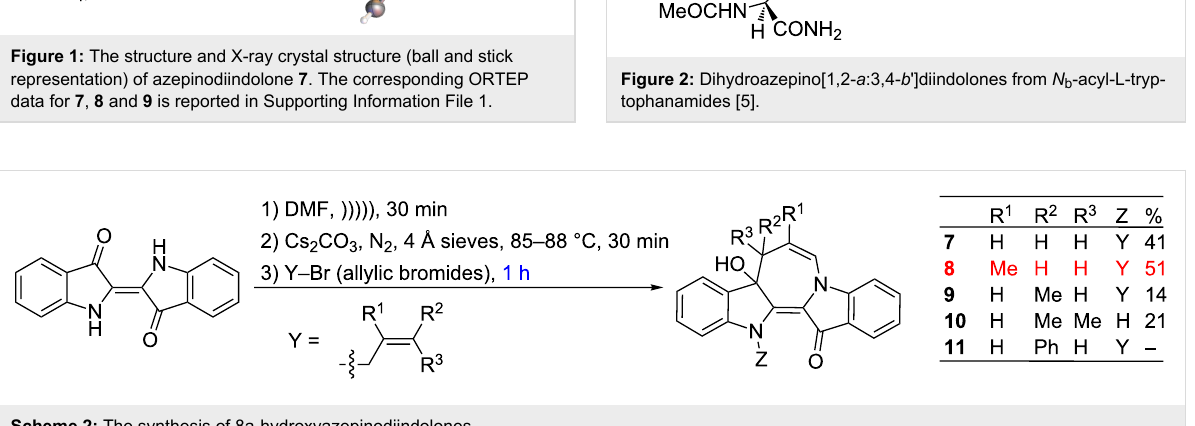
Scheme 2: The synthesis of 8a-hydroxyazepinodiindolones.